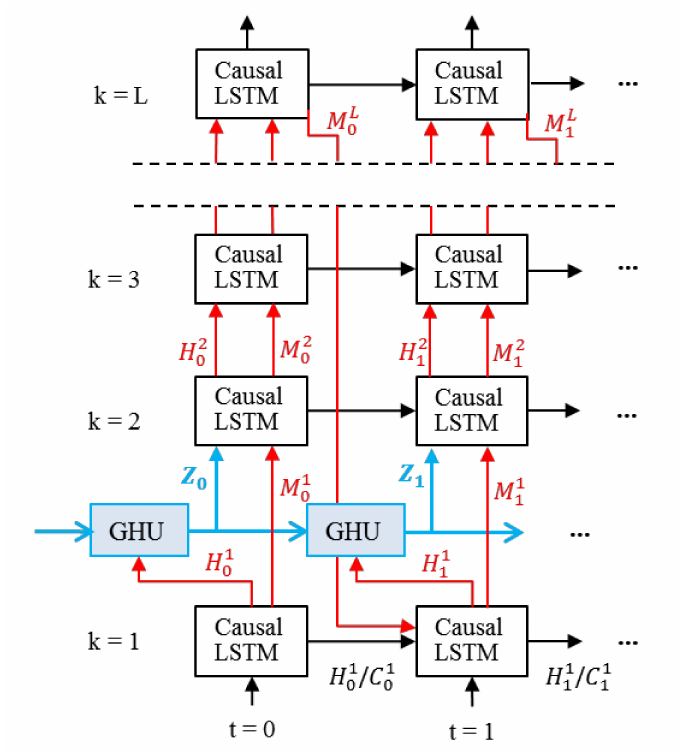
Figure 2. PredRNN ++ architecture of the model. Blue parts indicate the gradient highway connecting the current time step directly with prior inputs, while the red parts show the deep transition pathway. Where t denotes time step, k denotes kth hidden layer in the stacked model, M k C k is the temporal memory, H k is the final output (determined by the dual memory states) and Z t is the t t hidden state, provided by “gradient highway unit” (GHU). Source: adapted from Wang et al.